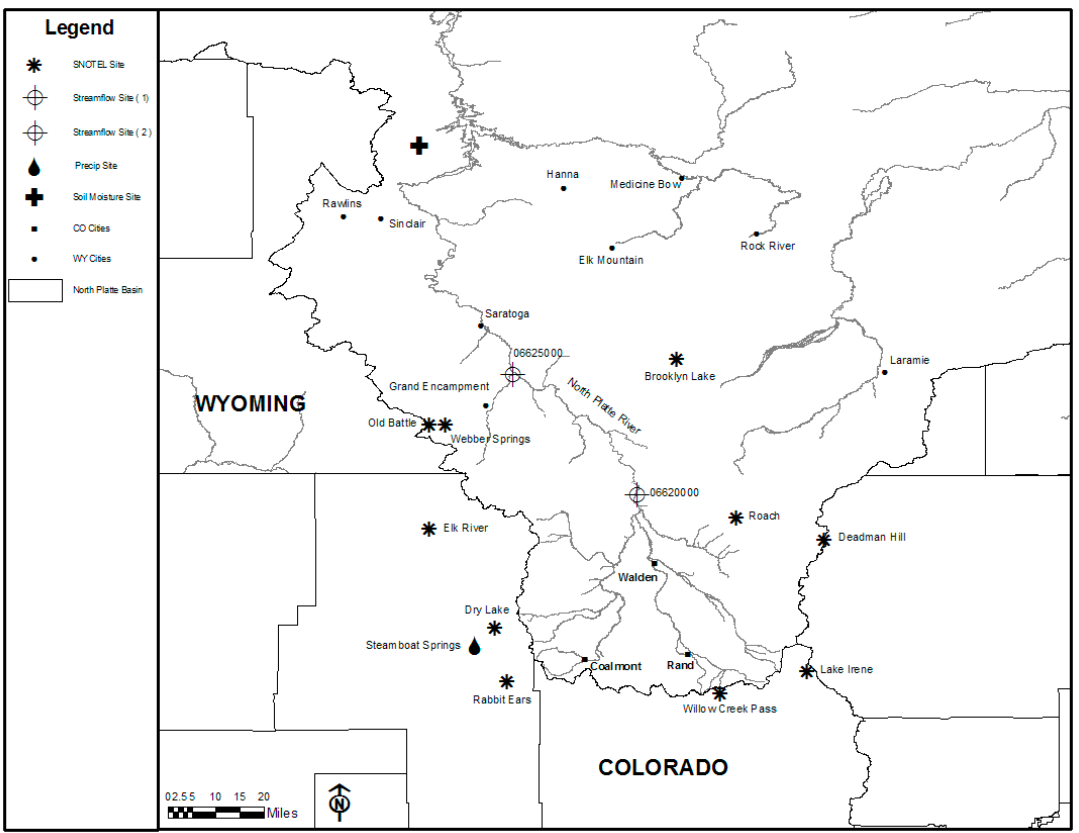
Figure 1. Location map of the Wyoming North Platte River Basin.